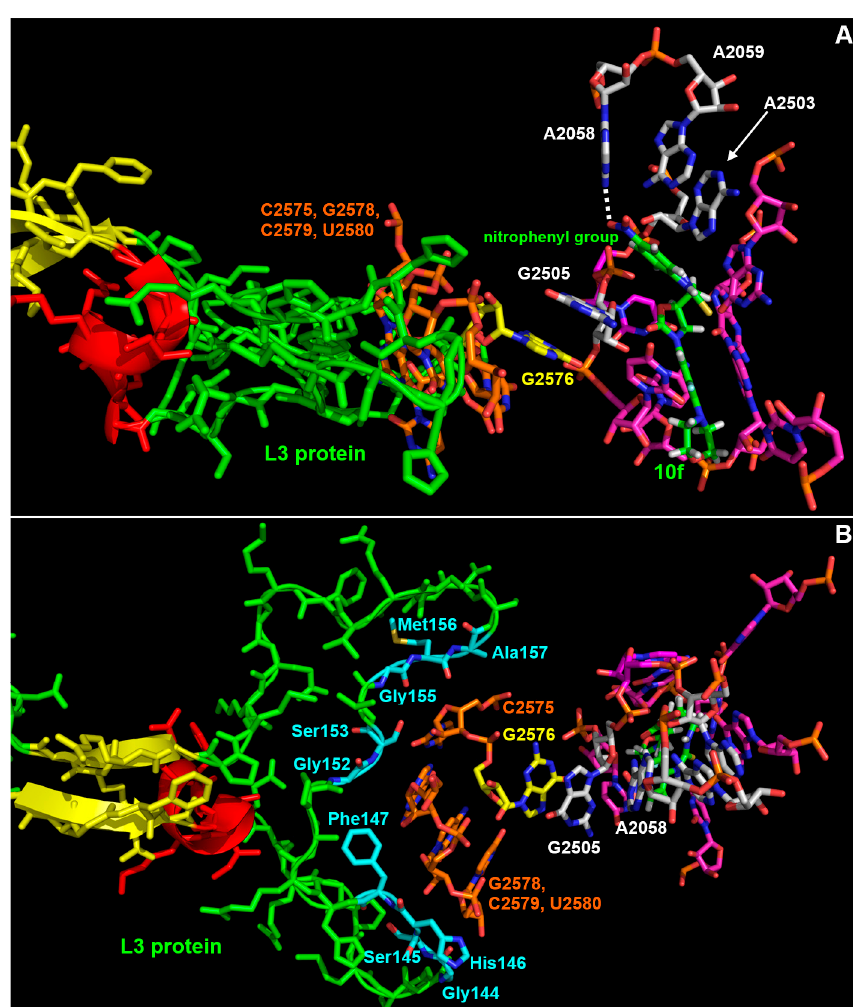
Figure 4. Close-up of the linezolid binding pocket in the model of the complex 10f/large ribosomal subunit. The color scheme is the same as in Figure 3 except that, in panel ( B ), the residues contacting nucleotides C2575, G2578, C2579 or U2580 are colored by atom type (nitrogen atoms are shown in blue, oxygen in red, carbon atoms in cyan). The dashed white line in panel ( A ) indicates the possible H-bond between the nitro group of 10f and the NH 2 group at position 6 of A2058.